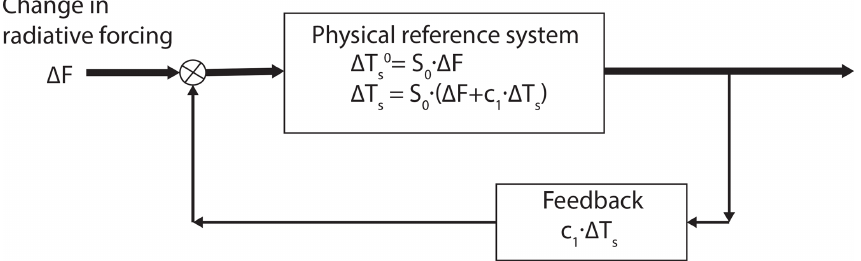
Figure 2. Illustration of a climate feedback mechanism. An increase (cid:49)F in radiative forcing leads to a change in the surface temperature depending on the magnitude and sign of the sensitivity parameter S 0 . The temperature change (cid:49)T s in the presence of feedback is different from the case without feedback ( (cid:49)T 0 s ). If, for example, the albedo (reflectivity) decreases/increases with rising temperatures (i.e. c 1 < 0 or c 1 > 0), the surface temperature change will be larger/smaller than in the absence of the